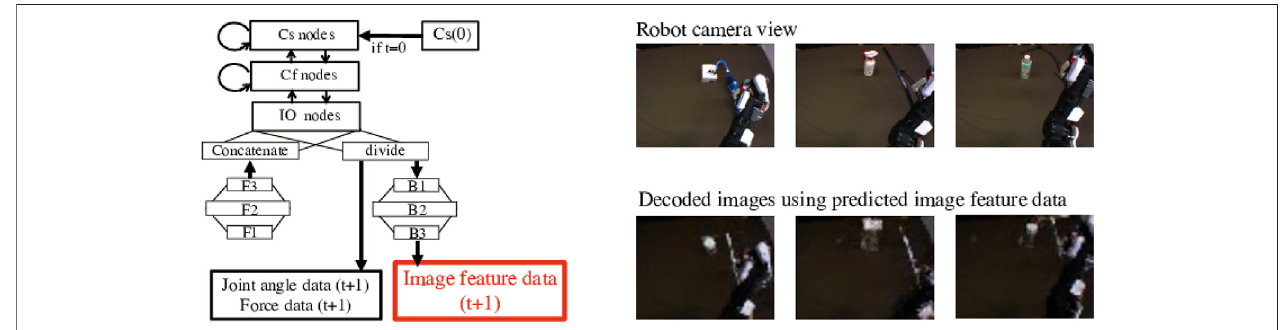
FIGURE 10| Decodedimagesusingpredictedimagefeaturesoutputfromthemotiongenerationmodule.Theoriginalcameraimagesaretakenduringthemovement dealingwiththeunknowntoolsandtheobjectsshowninthebottomof Figure2 .Althoughthedecodedimagesshowssimilarcolorofthetrainingtoolsandobjectssincethe feature extraction module recognizes their features based on the training ones, they represent the shape, size, position, and orientation of the tools and objects in the robot cameraview.Theyalsoshowthepositionoftherobotarm.Itcanbecon fi rmedthatthemotionwasgeneratedwhilecapturingtherealtimestateduringthemovement.